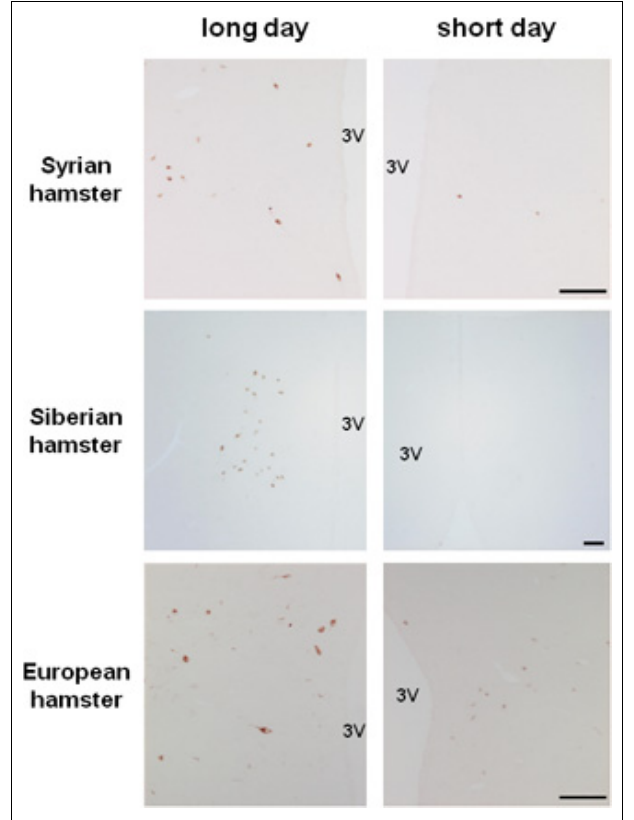
FIGURE 1 | Photoperiodic variations in RFRP immunoreactivity in the dorsomedial hypothalamus of male Syrian, Siberian, and European hamsters raised in long day or short day conditions. Scale bar = 100 μ M, 3V: third ventricle. RFRP antibody was generously provided by Dr. Greg Anderson; Syrian and Siberian hamster pictures were kindly provided by Julien Bartzen and European hamster pictures by Cristina Saenz de